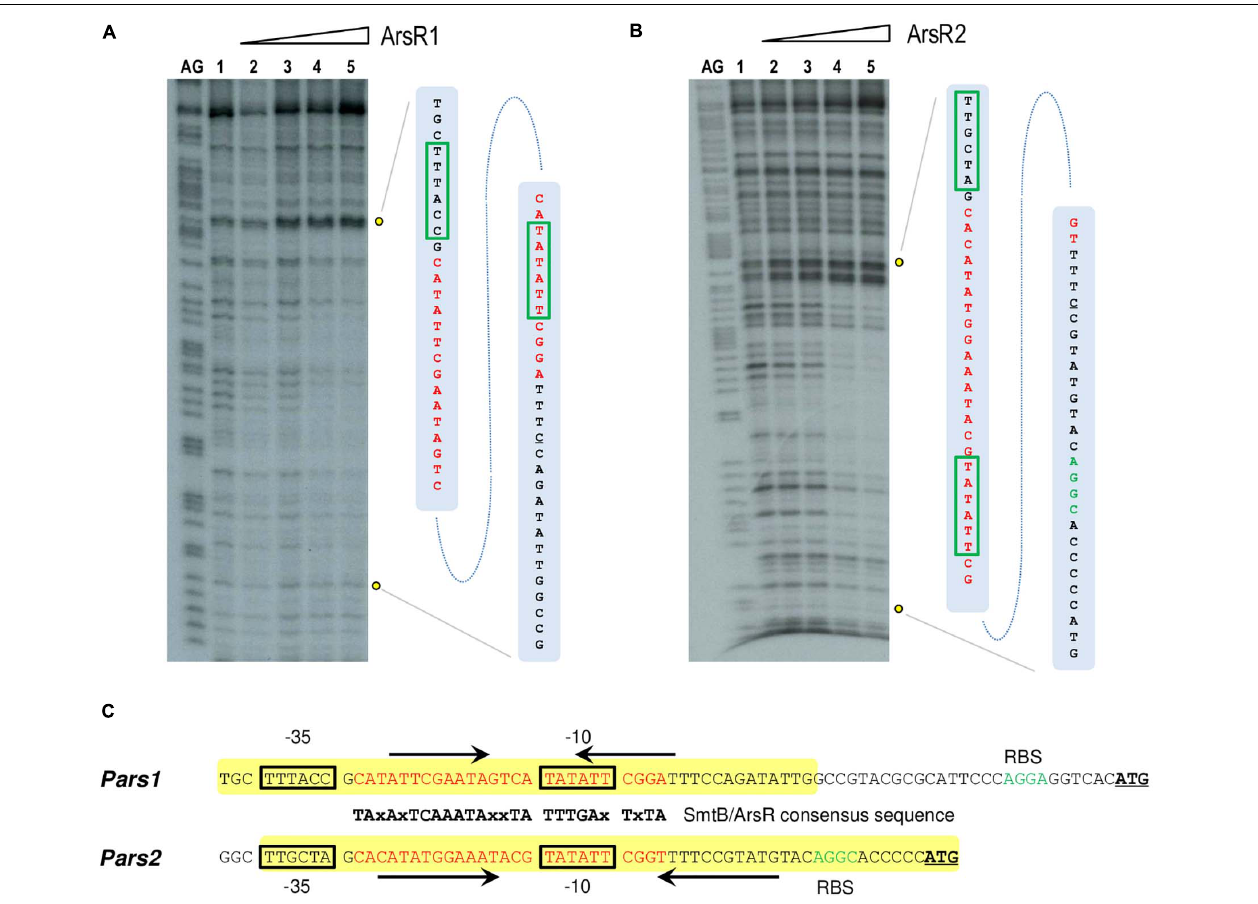
FIGURE 5 | (A,B) DNase I footprinting analysis of the interaction of purified 6His-ArsR1 and 6His-ArsR2 with the Pars1 and Pars2 promoter regions, respectively. The DNase I footprinting experiments were carried out using the Pars1 and Pars2 probes labeled as indicated in section “Materials and Methods.” Lanes AG show the AG Maxam and Gilbert sequencing reactions. Both lanes 1 show a footprinting assay in the absence of proteins. Lanes 2 to 5 show footprinting assays containing 25, 50, 100, and 250 nM purified 6His-ArsR1 or 6His-ArsR2, respectively. An expanded view of the promoters regions protected by purified 6His-ArsR1 and 6His-ArsR2 is shown at the right of each figure. The ArsR binding sites are marked in red. The –10 and –35 boxes are also underlined in green. (C) Promoter sequences at the upstream region of the ars1 and ars2 genomic regions. The –35 and –10 motifs typical of σ 70 promoters are in black boxes. The sequences encompassing in each case the operator regions based on the consensus target sites for repressors of the SmtB/ArsR family (Busenlehner et al., 2003) are indicated in red along with their cognate palindromic sequences (marked by black arrows). The yellow box shows the protected region of DNA observed in the footprinting assay. The ribosomal binding sites (RBS) are marked in green. The leading codon of each arsR gene in either operon is underlined in